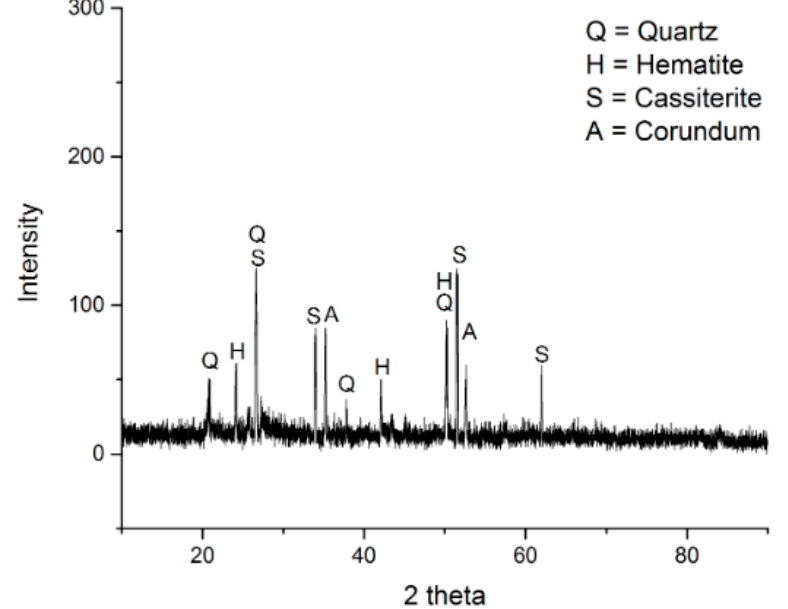
Figure 5. XRD (X-ray diffractometer) pattern of tin slag aggregate [14].